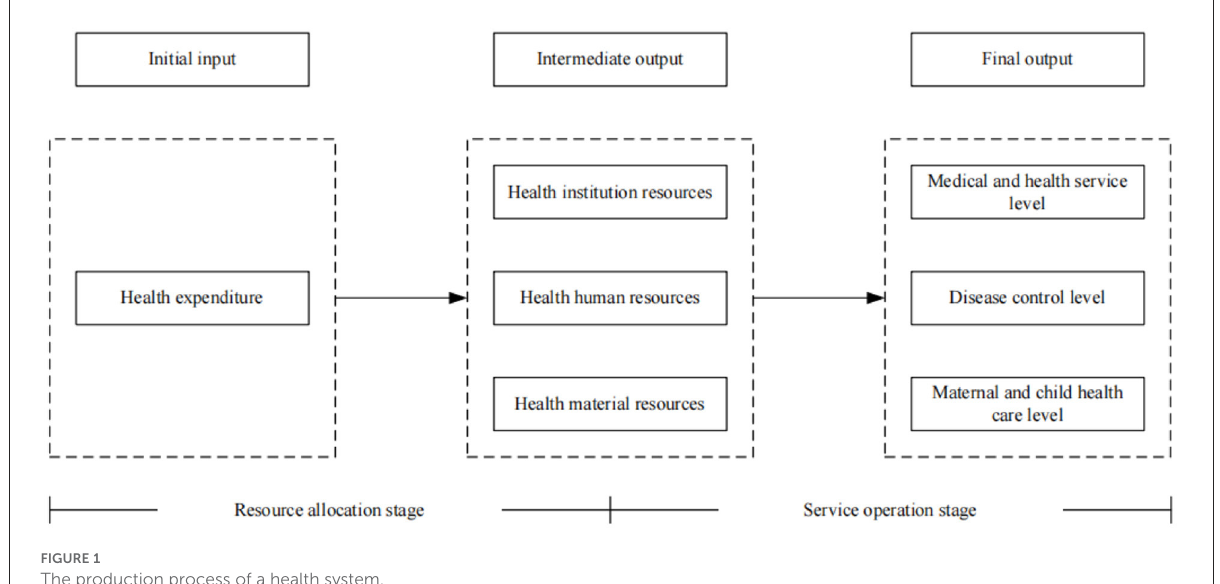
FIGURE1 The production process of a health system.